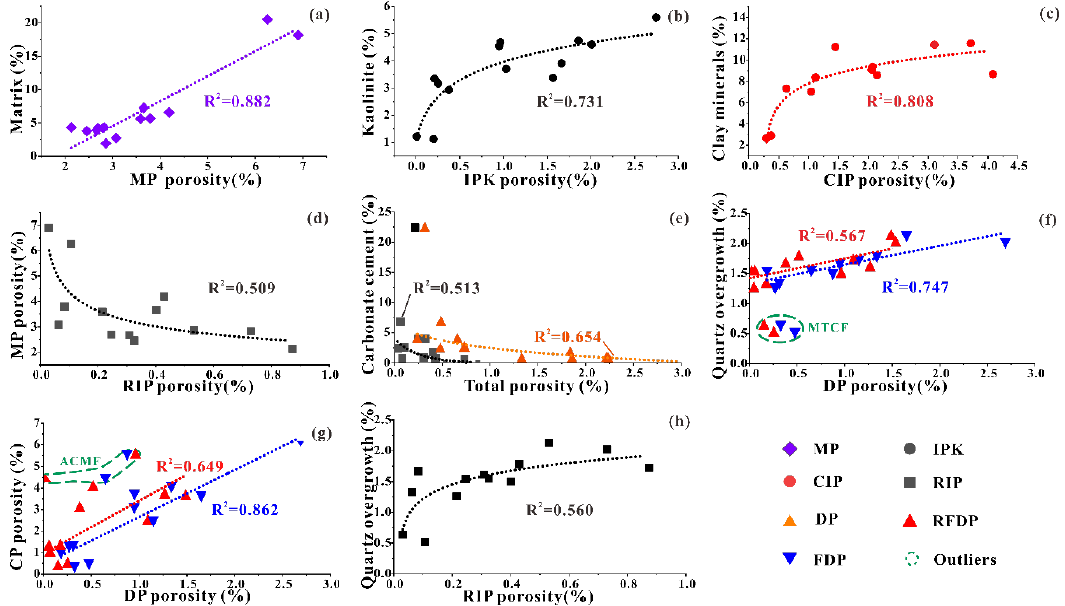
Figure 9. The correlation between the porosities of different types of pores and mineral compositions: ( a ) matrix pore (MP) porosity vs. matrix content, ( b ) intercrystalline pores of kaolinite (IPK) porosity vs. kaolinite content, ( c ) CIP porosity vs. clay minerals content, ( d ) MP porosity vs. residual intergranular pore (RIP) porosity, ( e ) the total porosity vs. carbonate cement content, ( f ) DP porosity vs. quartz overgrowth content; ( g ) DP porosity vs. clay-related pore (CP) porosity, and ( h ) RIP porosity vs. quartz overgrowth content.